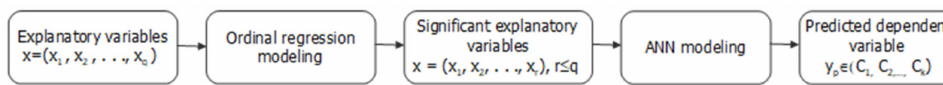
Figure 3. The two-stage ordinal regression and neural network